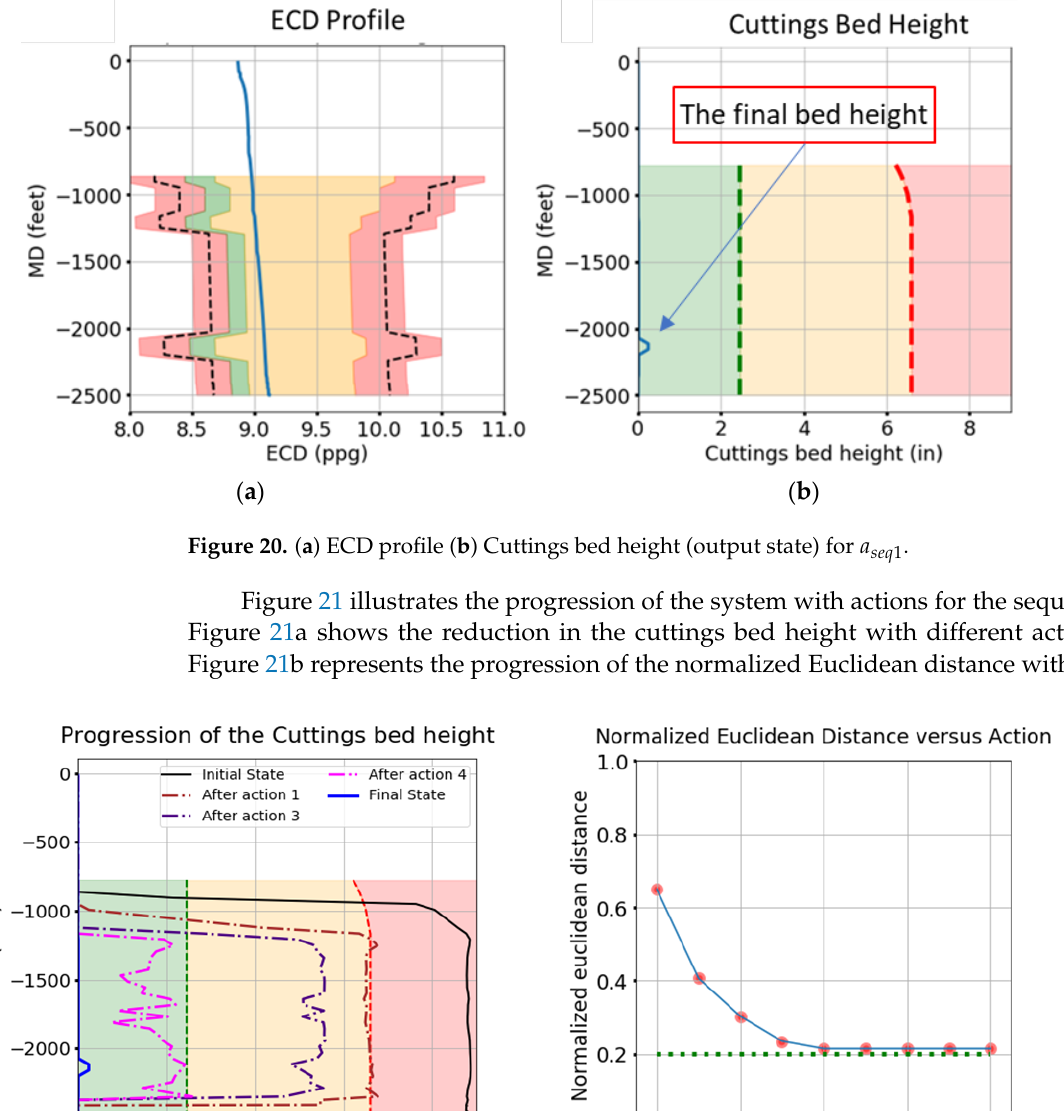
Figure 21. ( a ) Progression of the cuttings bed ( b ) Progression of the normalized Euclidean distance (blue line) of the system states for 𝑎 𝑠𝑒𝑞1 to an acceptable goal state (shown by the green dotted line, here taken to be a state at a normalized Euclidean distance of 0.2).